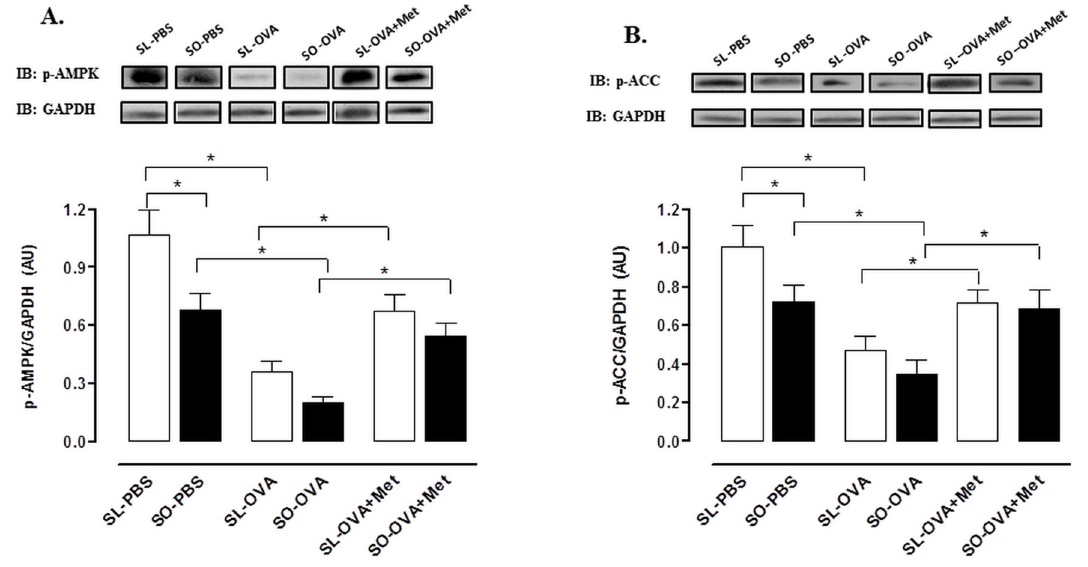
Figure 10. Effect of metformin treatment (300 mg/kg/day, two weeks) on phospho-AMPK (A) and phospho-acetyl CoA carboxylase (ACC) (B) expression in lung tissue at 48 h following intranasal challenge with ovalbumin in sensitized mice. Each column represents the mean ± SEM (n = 6) for the following groups of mice: sensitized lean treated with vehicle and instilled with PBS (SL-PBS), sensitized obese treated with vehicle and instilled with PBS (SO-PBS), sensitized lean treated with vehicle and challenged with OVA (SL-OVA), sensitized obese treated with vehicle and challenged with OVA (SO-OVA), sensitized lean treated with metformin and challenged with OVA (SL-OVA + Met) and sensitized obese treated with metformin and challenged with OVA (SO-OVA + Met). The membranes were normalized with GAPDH. * p<0.05. doi: